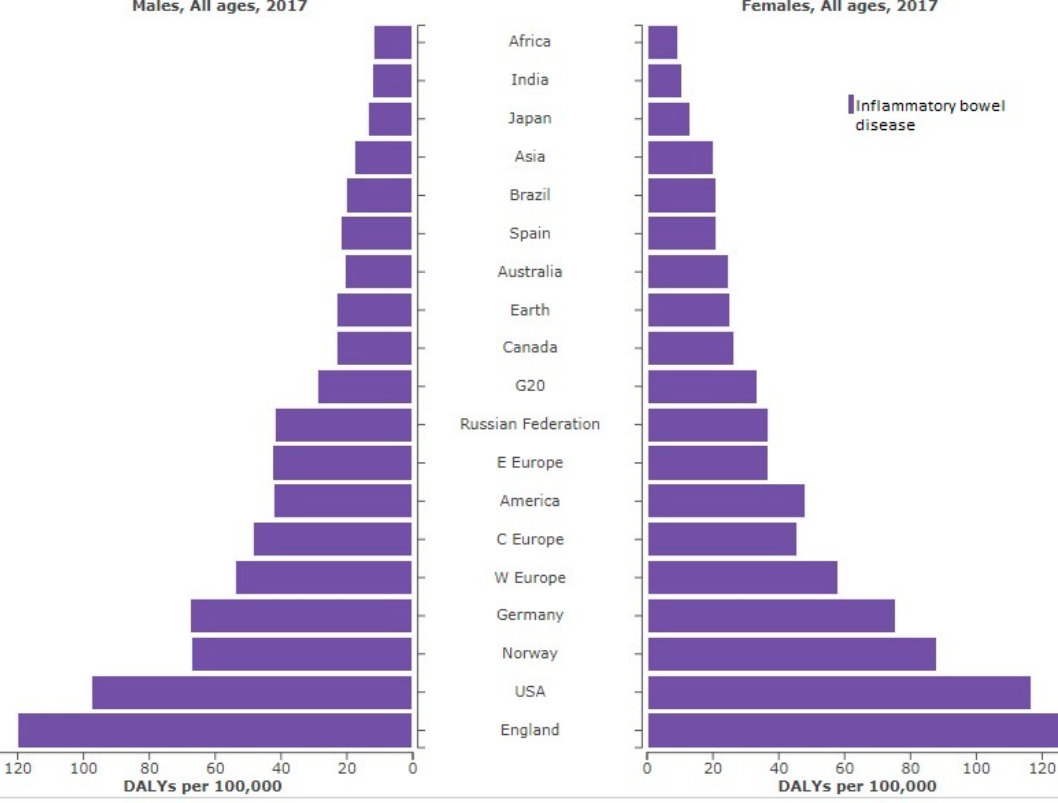
Figure 1. DALYs (disability-adjusted life years) per year of inflammatory bowel disease (IBD) in selected locations in 2017, ordered by incidence and sex.